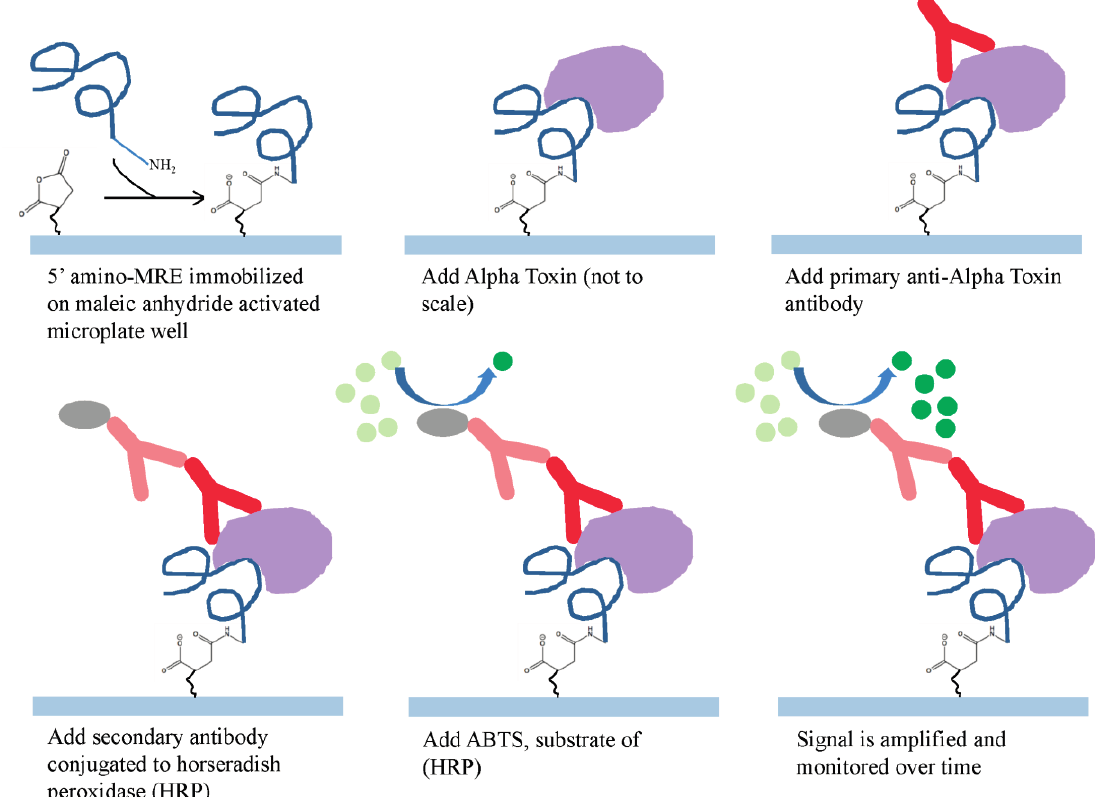
Figure 3. Illustration of the ssDNA MRE modified ELISA assay. The ssDNA MRE was used as the capturing element in the sandwich ELISA assay. The curved blue line attached to NH 2 represents the 5' amino modified MRE. The purple irregular shape represents alpha toxin. The red “Y” shape represents the primary antibody against alpha toxin. The grey oval represents horseradish peroxidase (HRP) conjugated to a secondary antibody (pink). The light green circle represents the substrate of HRP and the dark green circle represents the metabolite of HRP, which is detected with absorbance